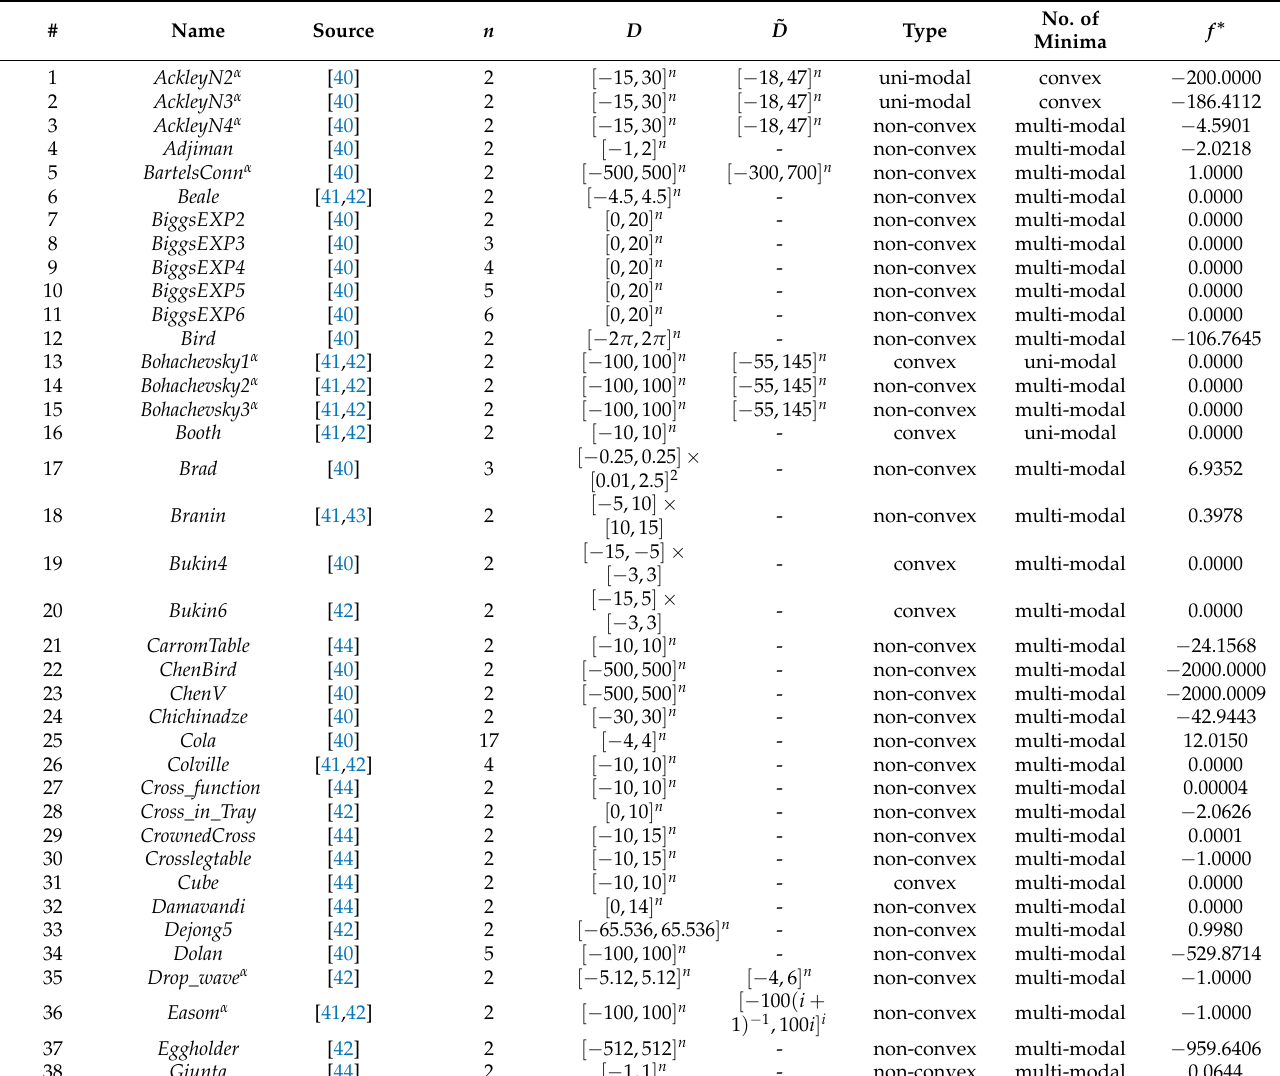
Table A1. Key characteristics of box-constrained global optimization problems with fixed n from DIRECTGOLib v1.2 [35]. Data adapted from